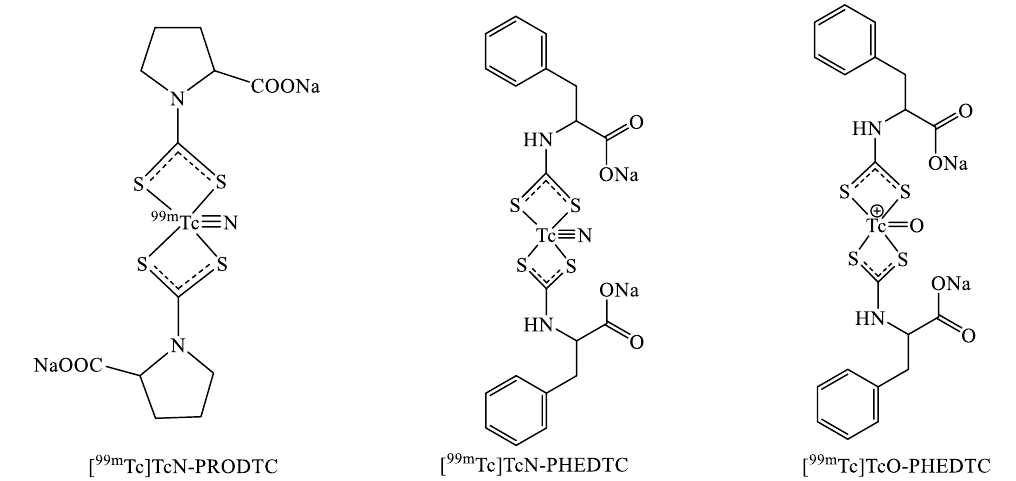
Figure 1. The proposed chemical structures of some mentioned radiolabeled amino acids.